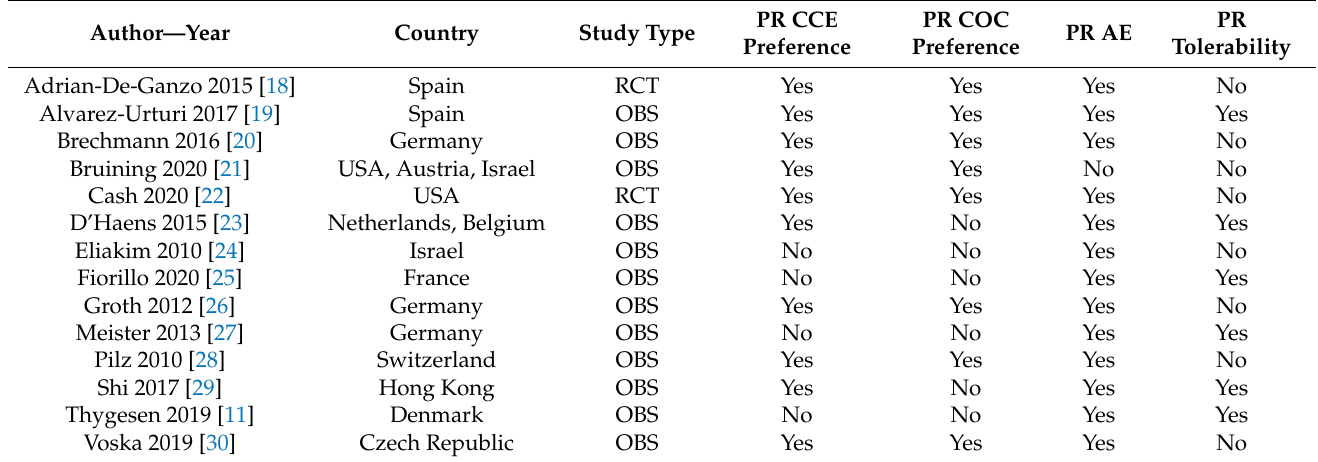
Figure 1. Consort diagram of the systematic review. Abbreviations: CCE, colon capsule endoscopy; PRO, patient-reported outcomes. Table 1. Study